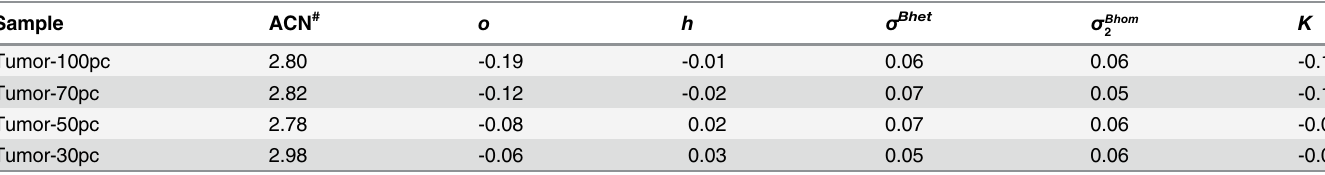
Table 1. Parameters estimation on dilution series